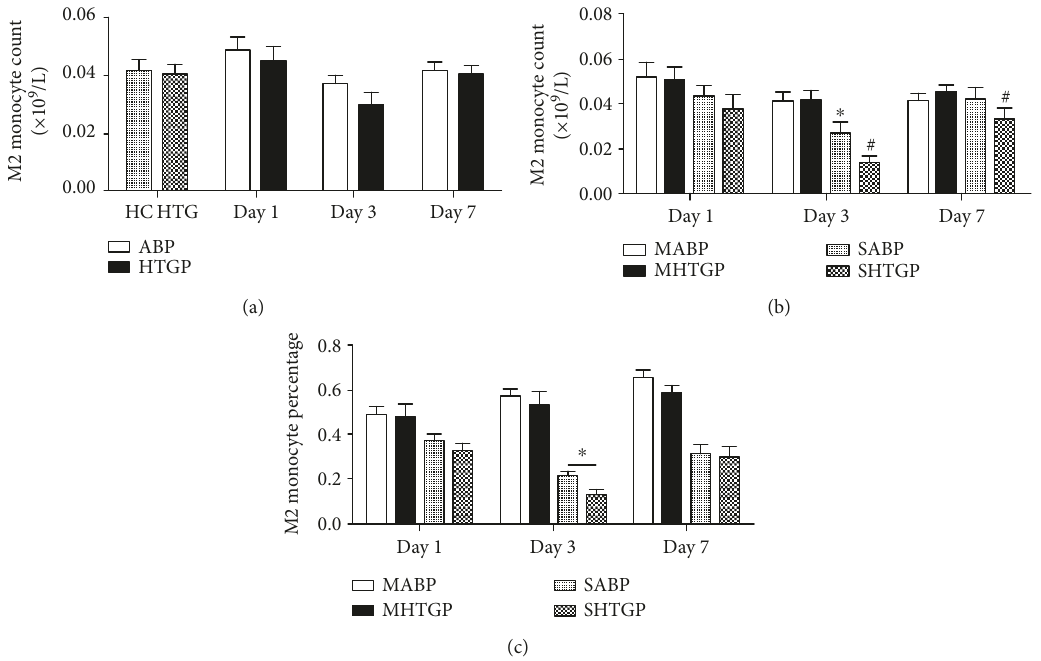
Figure 3: M2 monocyte count and percentage in all subjects on days 1, 3, and 7. ∗ P < 0 05 compared with HC group (a) or MABP group (b). # P < 0 05 compared with HTG group (a) or MHTGP group (b). ∗ P < 0 05